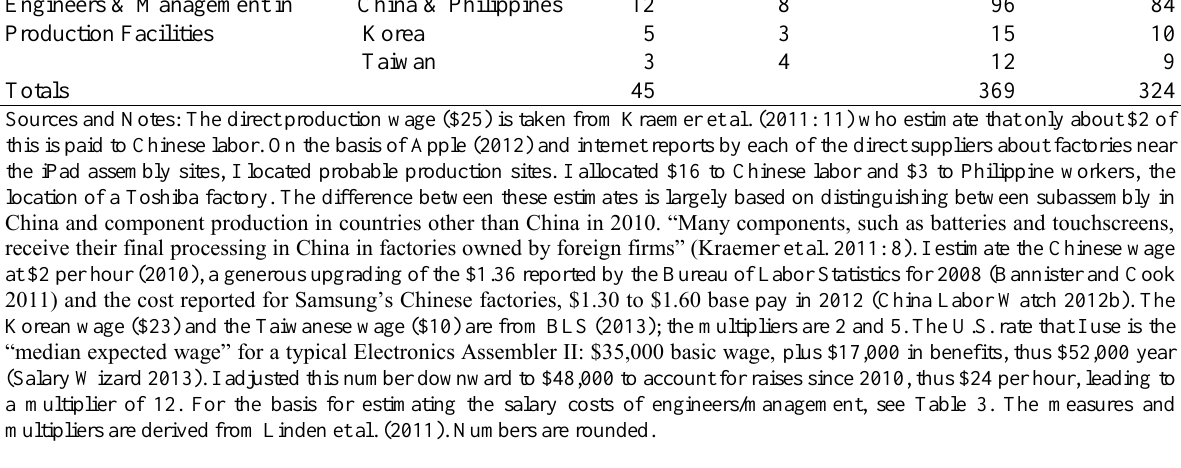
Table 6. Dark Value from Underpaid Labor in the iPad Tier 2 Suppliers Basis Waged Labor in Direct